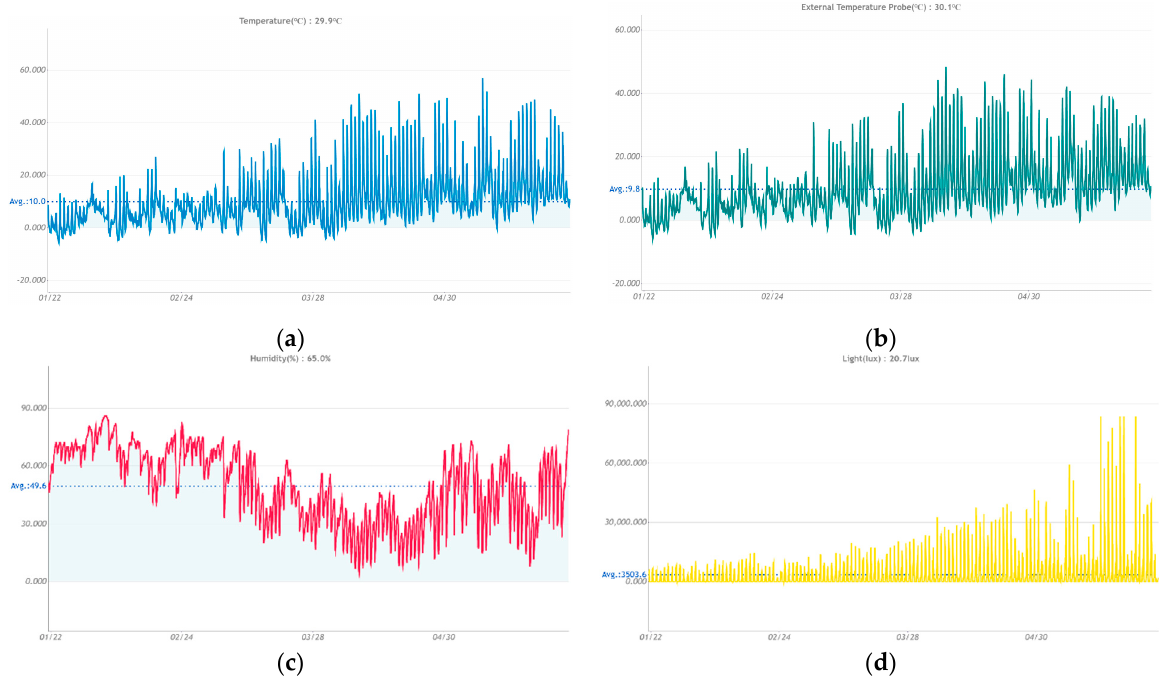
Figure 5. Graphical interpretation of the obtained measurement results using T szyn WS1 WIFI measurement station: ( a ) ambient temperature; ( b ) temperature inside the rail head; ( c ) humidity; ( d ) ambient lighting.